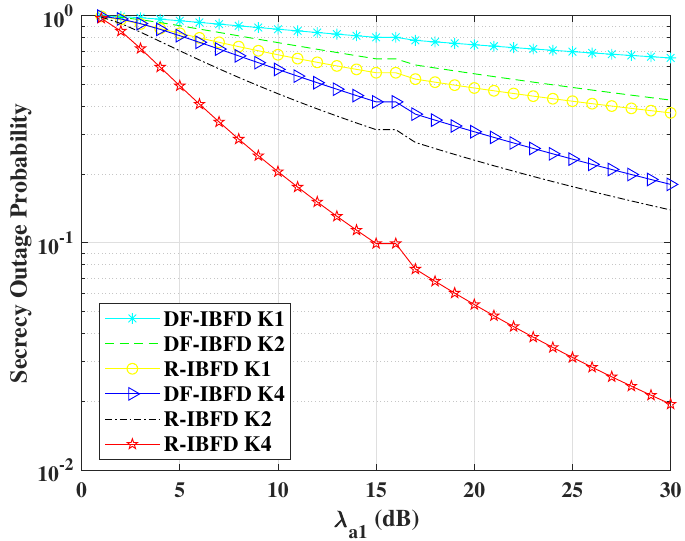
Figure 5. Secrecy outage probability comparison for Reflective In-Band Full-Duplex (R-IBFD) and Decode-and-Forward In-Band Full-Duplex (DF-IBFD) with C th = 1, ζ 12 = ζ 11 = 12 dB, K = 1, 2 and 4 and ζ 1 e is calculated with respect to Rayleigh flat fading and respective interference.